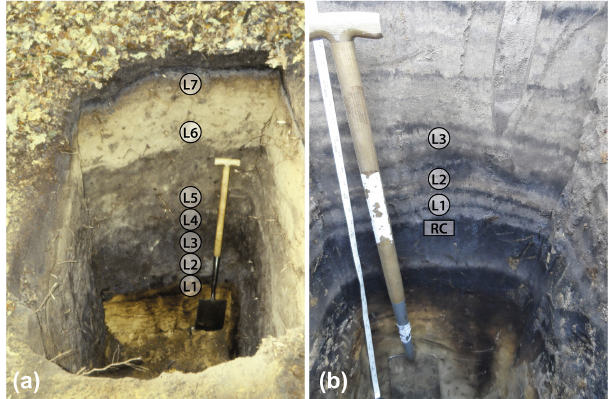
Figure 12. The soil archives of the Bedafse Bergen (left: Rakt; right: Bedafse Bergen). The sample locations for OSL are indicated with rings, and for 14 C with a